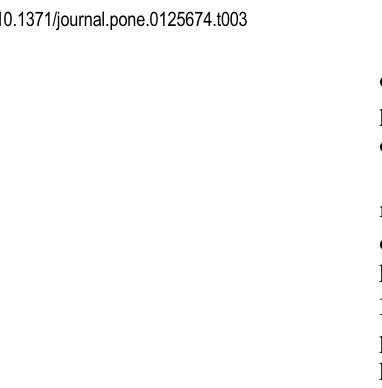
The signi fi cant values are in bold and SE stands for standard error.